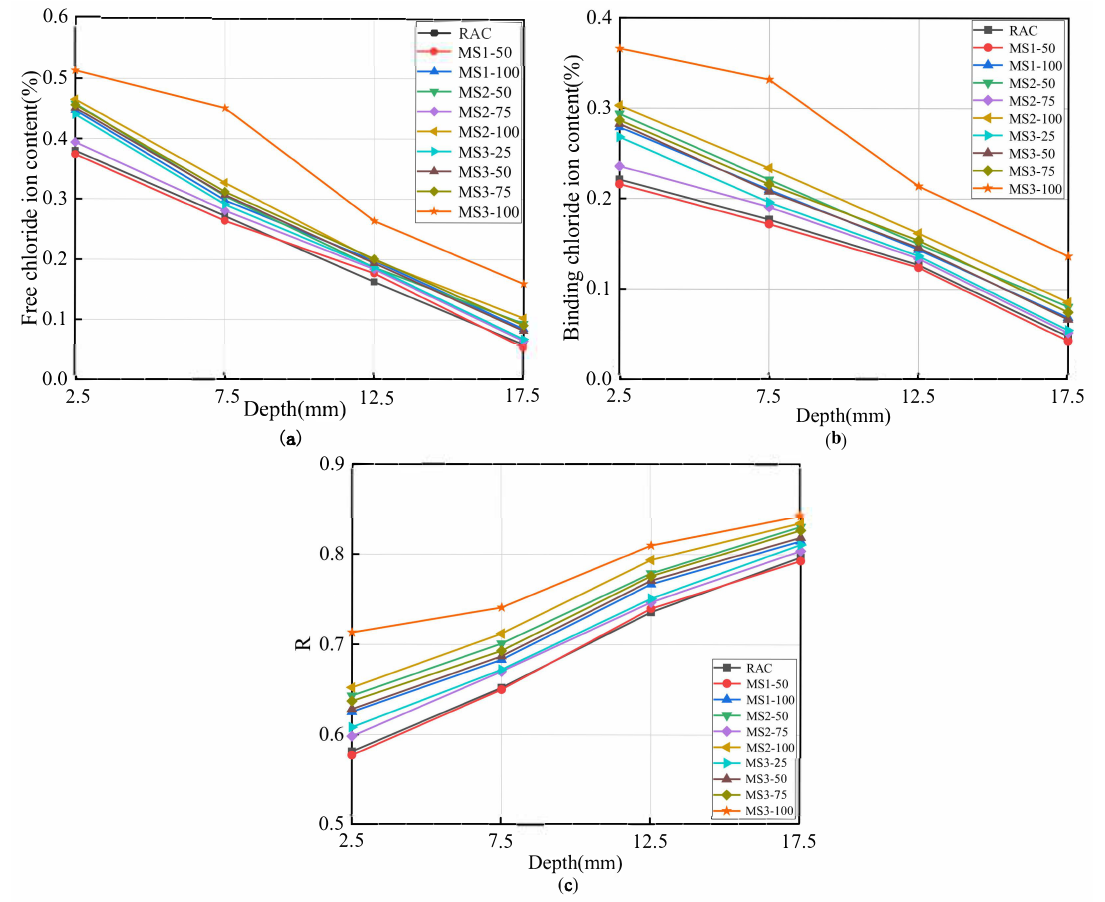
Figure 10. Relationship between chloride content and diffusion depth of concrete: ( a ) free chloride ion content; ( b ) bound chloride ion content; ( c ) chloride binding